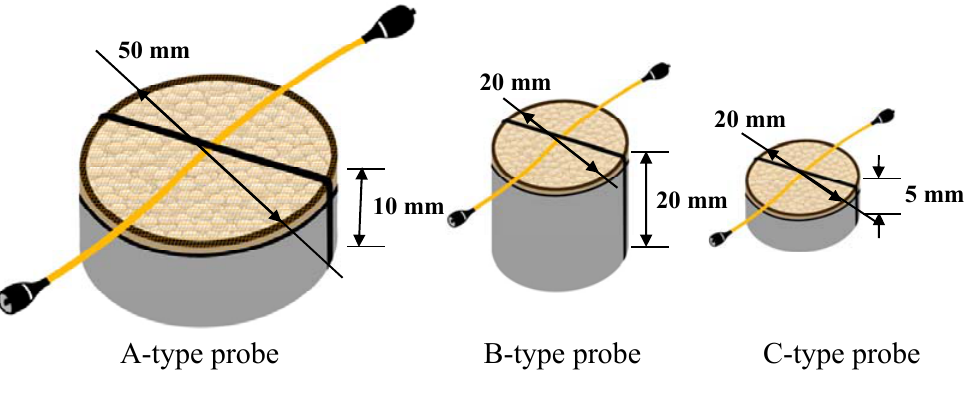
Figure 6. Fiber optic sensor probes using three types of